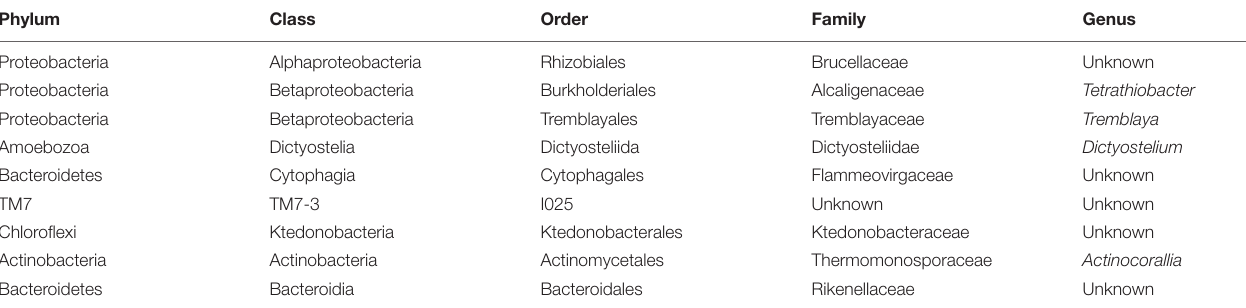
TABLE 2 | Classification of microbial genera found at significantly higher abundance in soil samples containing Yersinia .